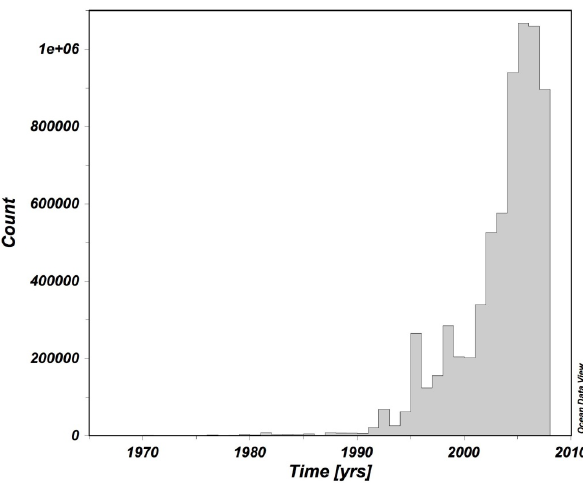
Figure 1. Number of data points per year during the period 1968 to 2007 included in SOCAT version 1.5. 4